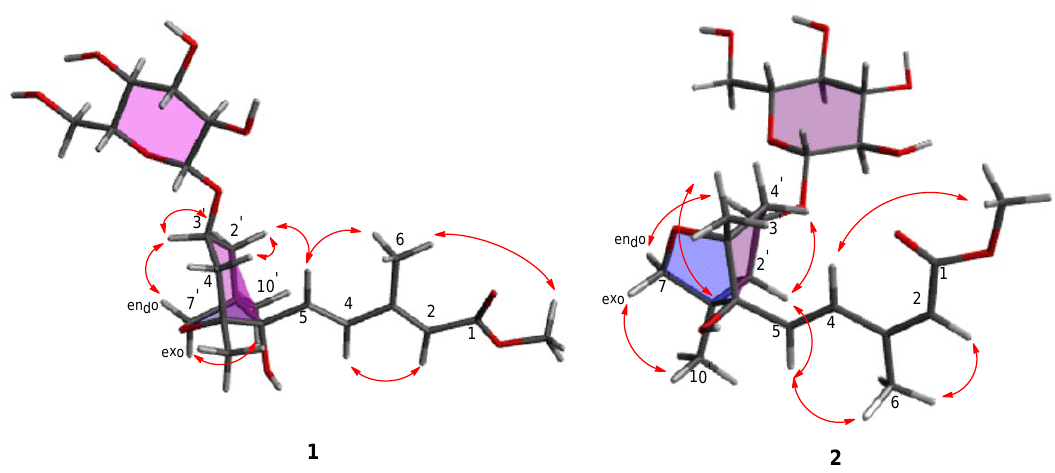
Figure 3. Key rotating frame Overhauser effect spectroscopy (ROESY) (arrows) correlations of compounds 1 and 2 .